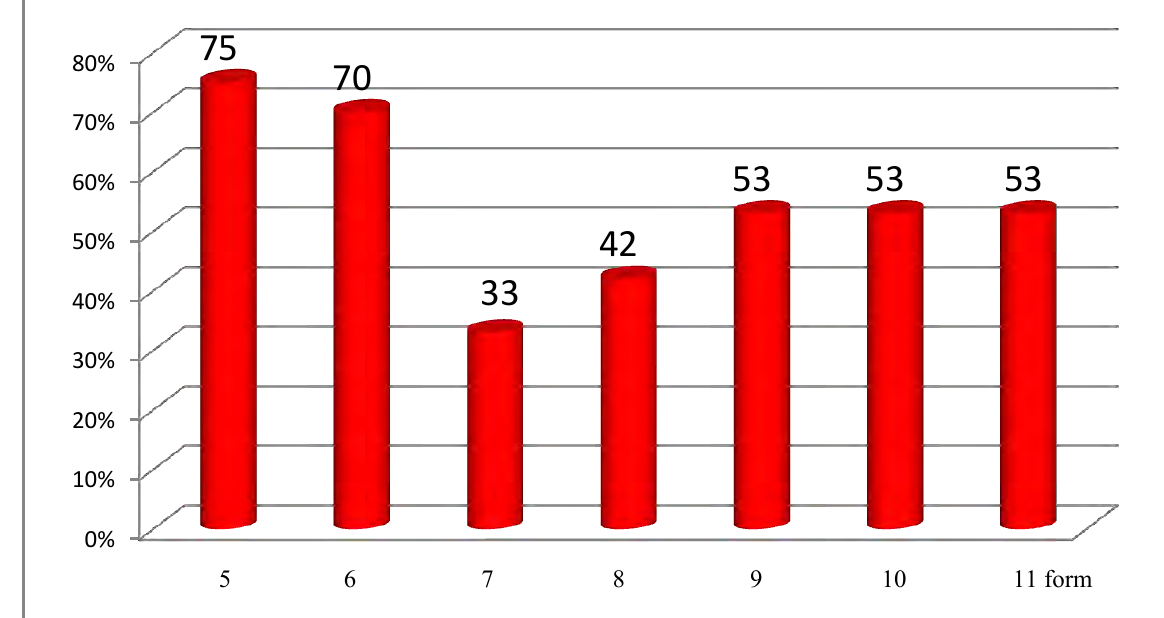
Fig.2. Indicators of 5-11 forms pupils’ activity in systemic physical culture-sports trainings (girls)